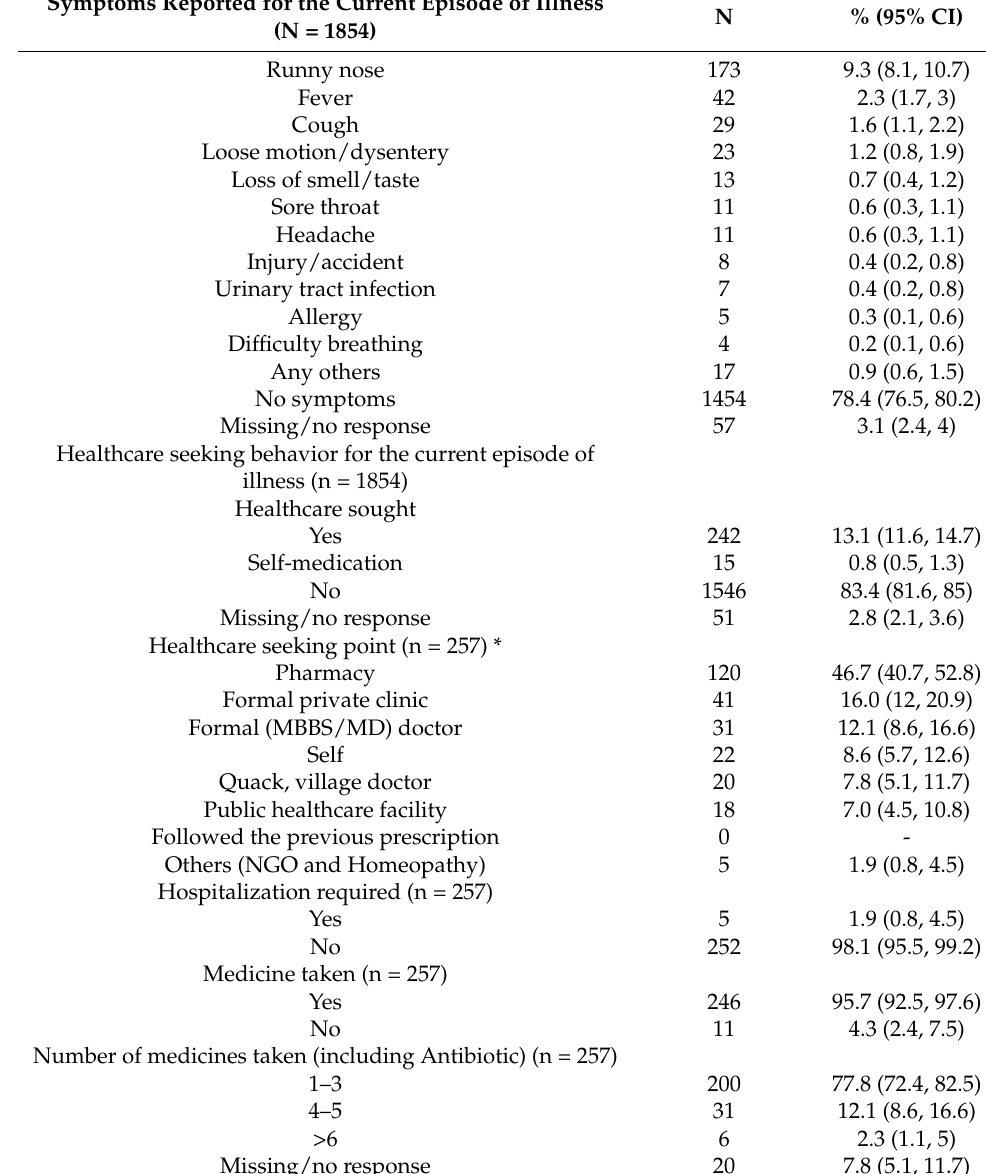
Table 3. General illness among the general population during the COVID-19 pandemic in Bangladesh. Symptoms Reported for the Current Episode of